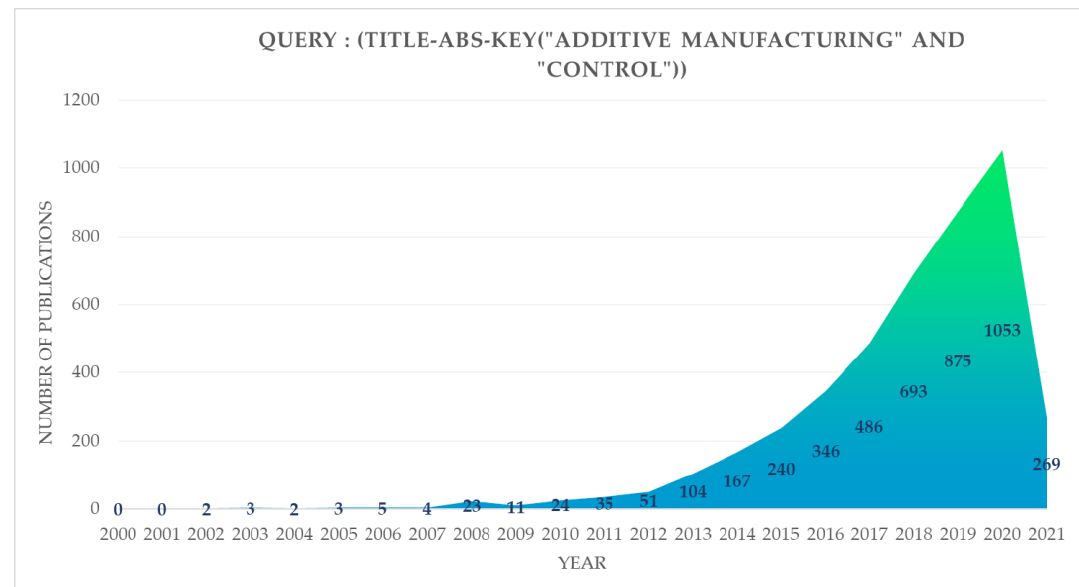
Figure 2. Evolution of publications regarding AM and control, based on Scopus database and query: (TITLE-ABS-KEY ("additive manufacturing" and "control")). Accessed on 18 March 2021.